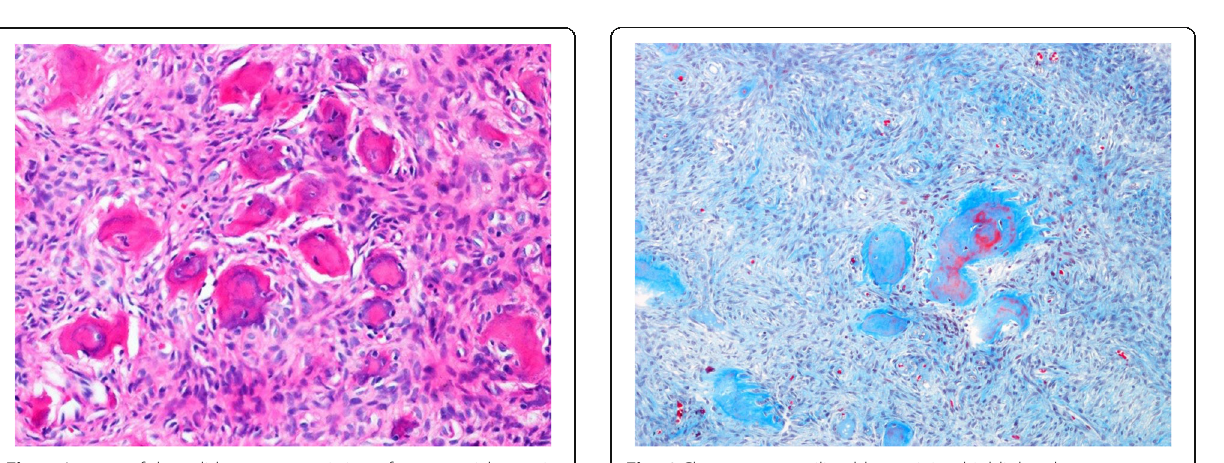
Fig. 4 An area of the solid tumour consisting of many ossicles set in cellular stroma